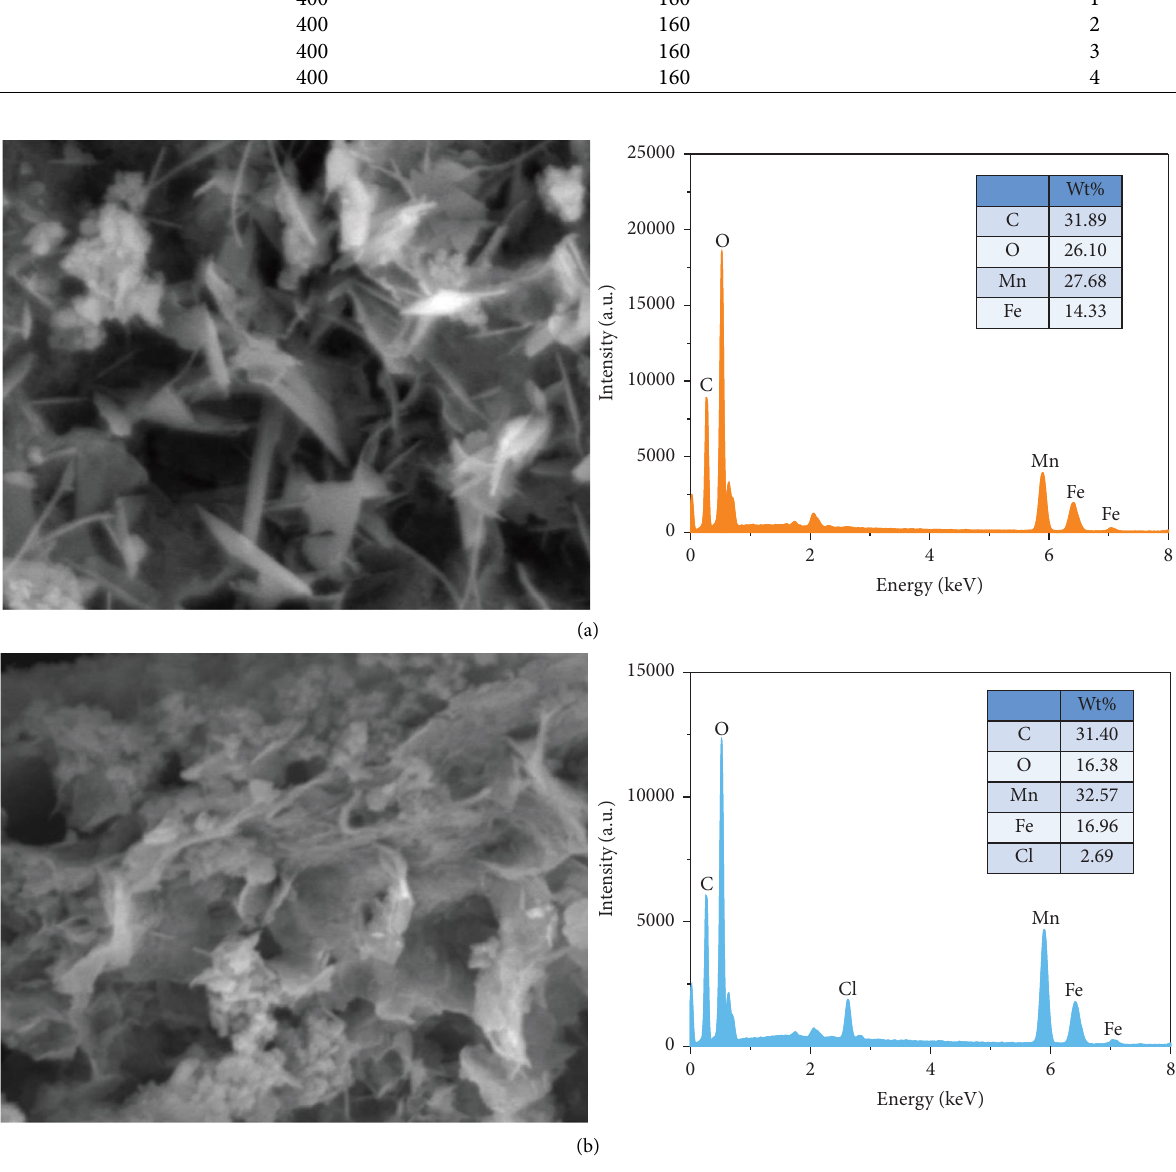
Figure 1: SEM-EDS images of Cl − before (a) and after (b) adsorption by FeMn-EDTA-LDHs.